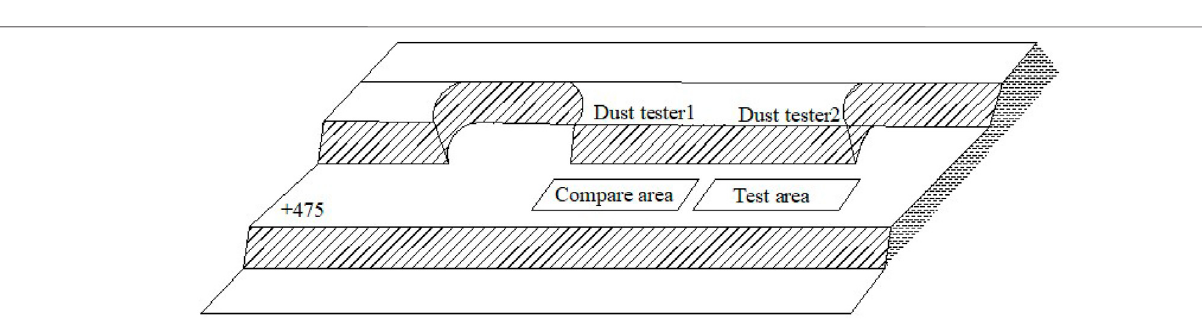
FIGURE 13 | Blasting dust suppression material. (A) Protective blanket. (B) Vacuuming cotton.